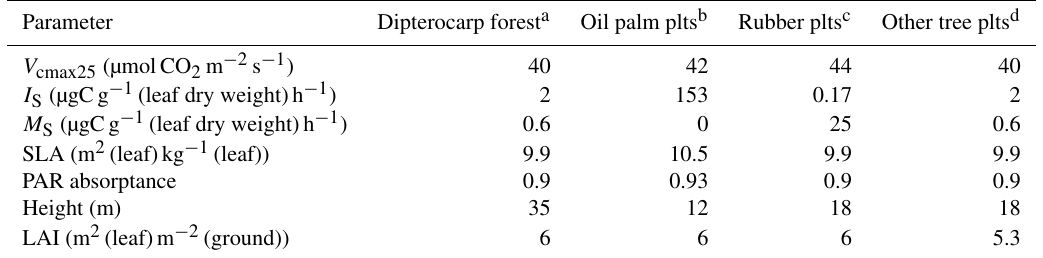
Table 1. Physical and photosynthetic parameters and isoprene and monoterpene basal emission rates assigned to four new land cover types in the ModelE2-YIBs source code. Plts is plantations.